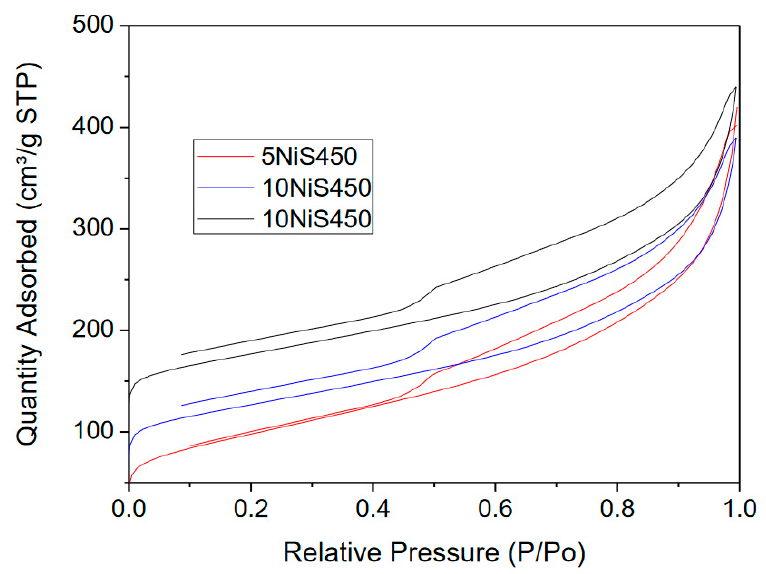
Figure 1. Nitrogen adsorption-desorption isotherms of 5NiS450, 10NiS450, and 20NiS450.